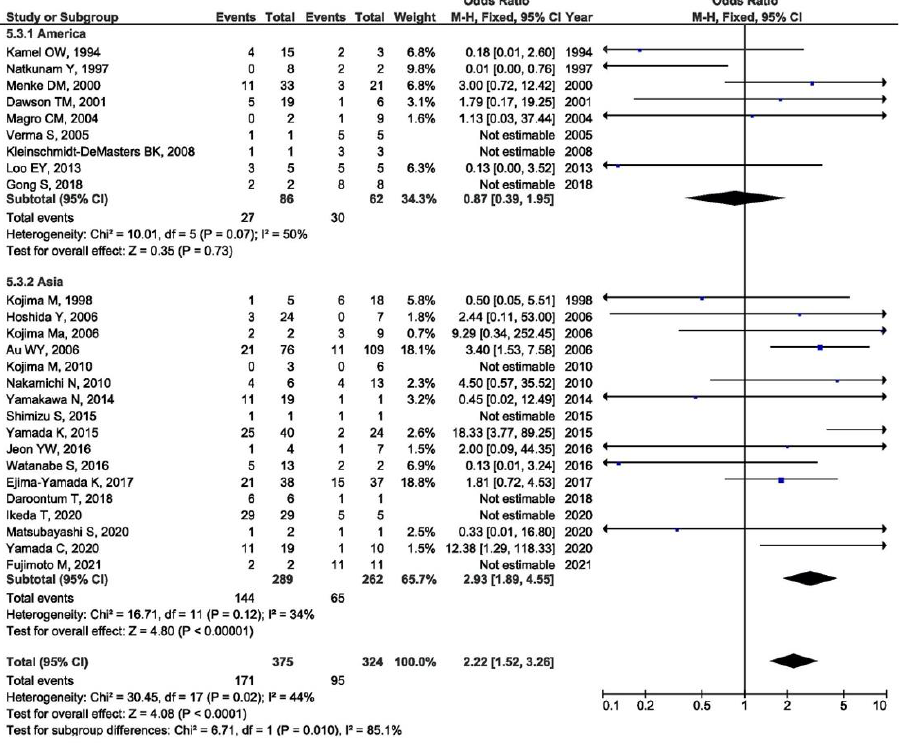
Figure 7. Meta-analysis of the difference in the positive EBV result in RA-LPD patients and all controls by the continent of origin (blue dot represent the odds ratio and black frame 95% CI of the odds ratio from each of the included studies. black arrows show that upper and/or lower limit of the 95%CI of odds ratio is below or above defined values on the x axis).